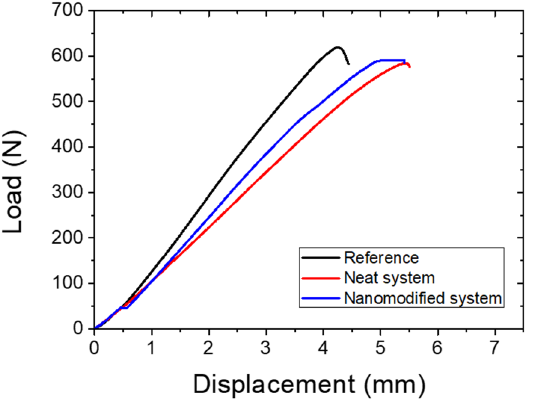
Figure 5. Representative plots of reference (black), neat (red line) and nanomodified (blue line) systems of mode-II specimens.